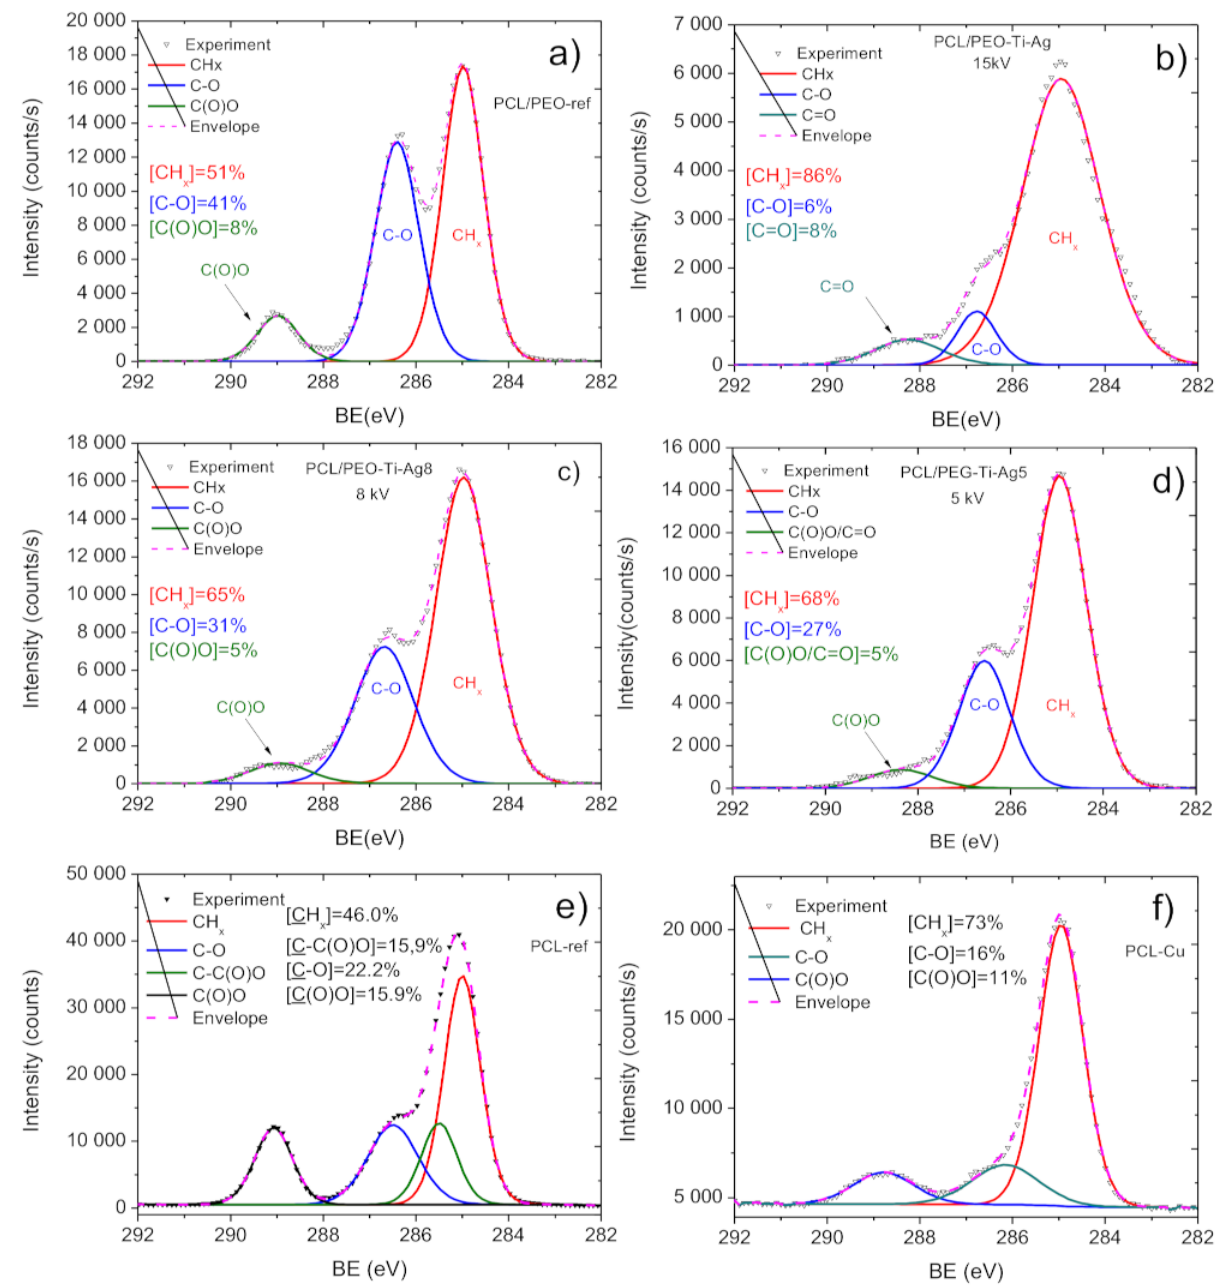
Figure 7. XPS C1s spectra and their curve fitting for samples PCL/PEO-ref ( a ), PCL/PEO-Ti0.5- Ag15kV ( b ), PCL/PEO-Ti0.3-Ag5kV ( c ), PCL/PEO-Ti0.3-Ag5kV ( d ), PCL-ref ( e ) and PCL-Cu ( f